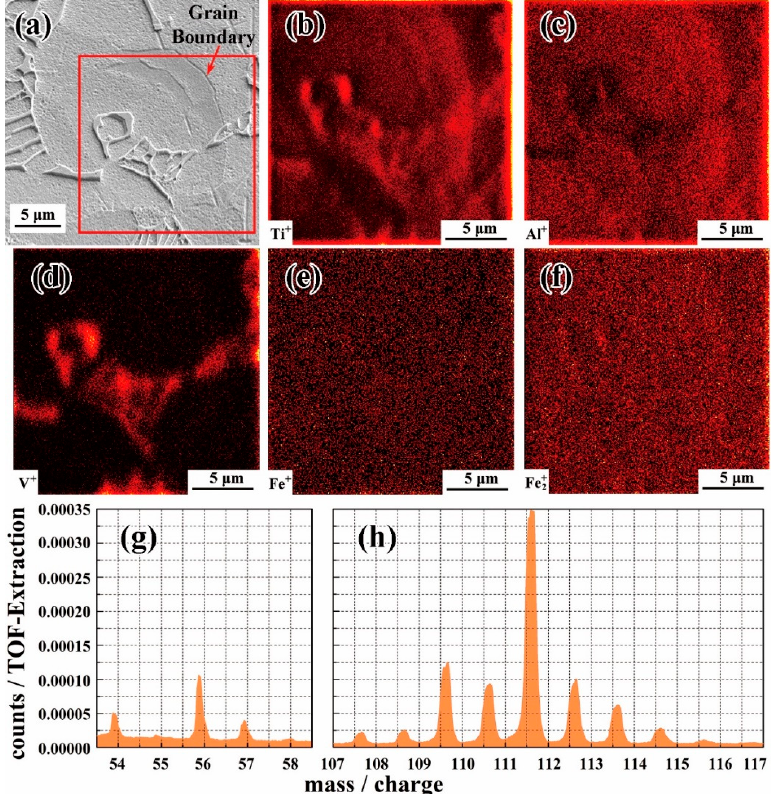
Figure 3. ( a ) The SEM micrograph of the alloy Ti-6Al-4V, ( b – f ) the secondary ion images of the region marked in ( a ), and the mass spectrum peaks (including the isotope peaks) of ( g ) Fe + and ( h ) Fe 2+